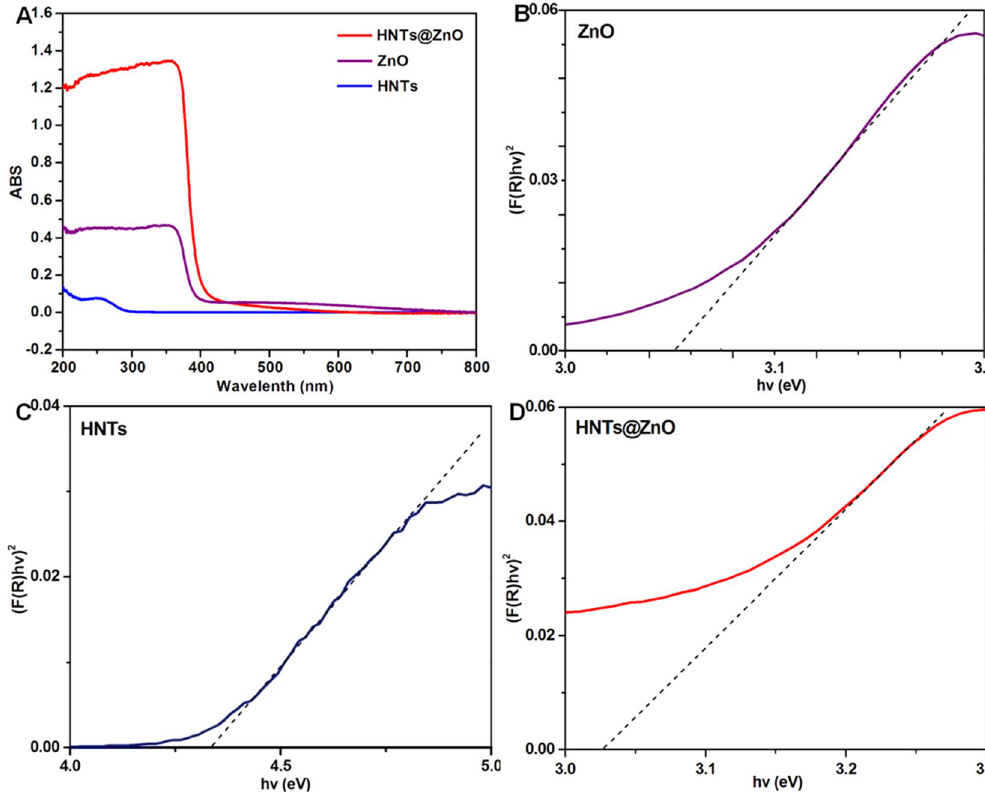
Figure 8. ( A ) UV-vis spectra of HNTs, ZnO and ZnO/HNTs; ( B – D ) DRS spectra of ZnO, HNTs and HNTs@ ZnO with the corresponding plots of [F(R ∞ )hv] 2 versus